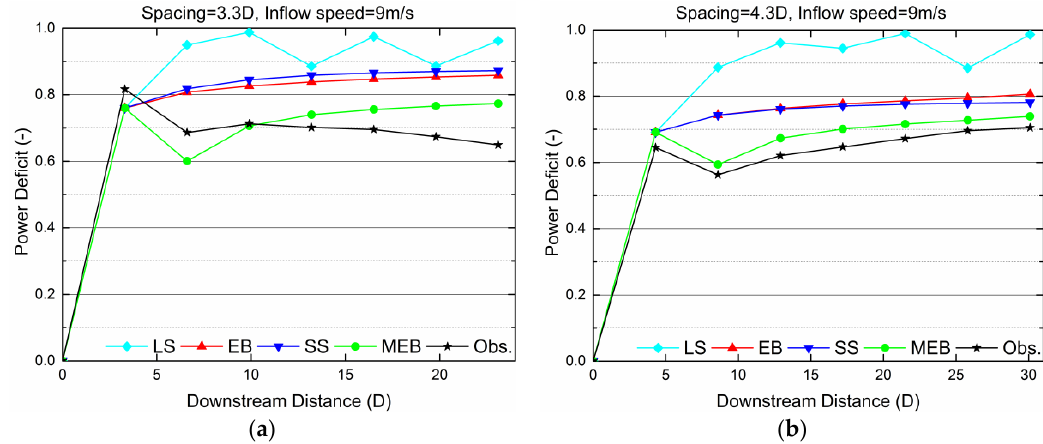
Figure 4. Lillgrund power deficit in a complete row with ( a ) 3.3D spacing and ( b ) 4.3D spacing. Energies 2019 , 12 FOR PEER REVIEW